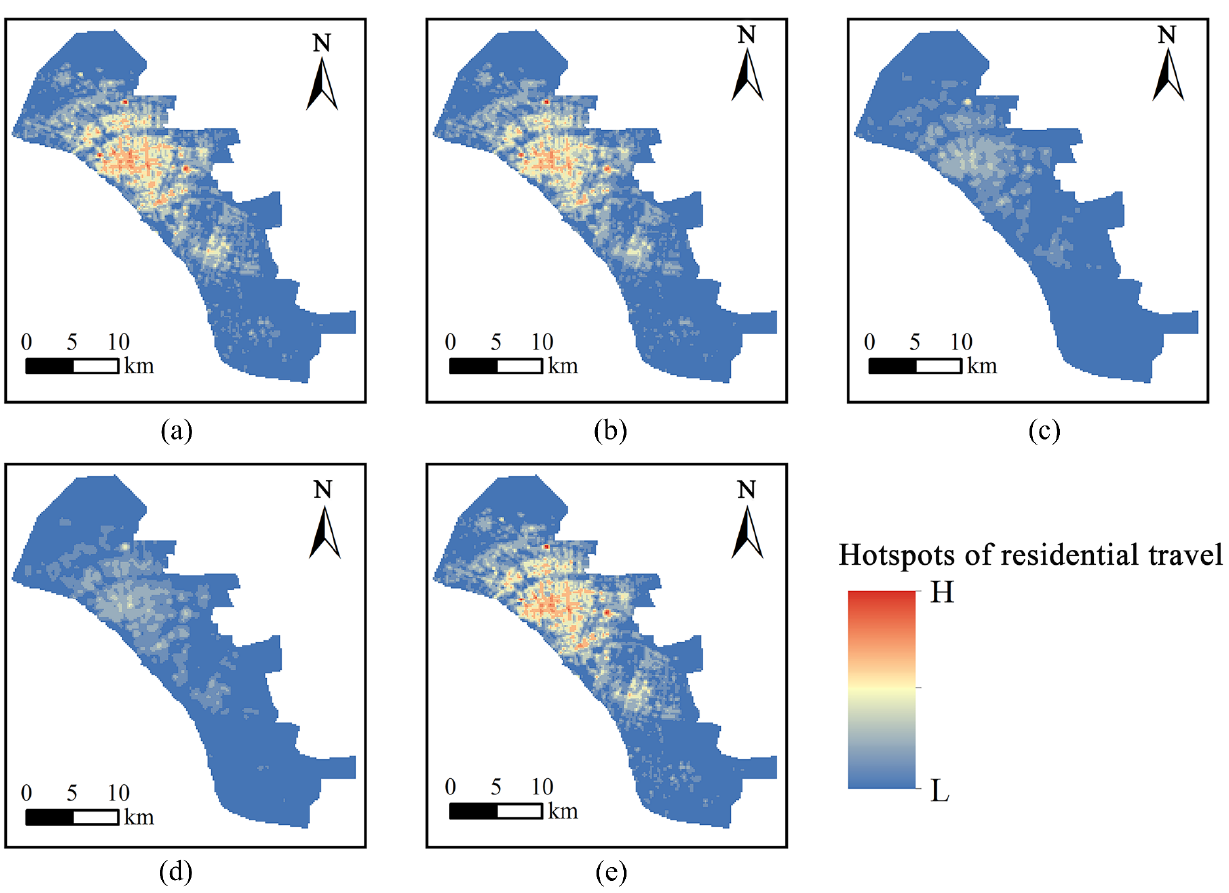
Figure 7. Urban hotspots of residential travel in ( a ) normal period of society, ( b ) early period of COVID-19, ( c ) outbreak period of COVID-19, ( d ) rework period of society, and ( e ) recovery period of society.